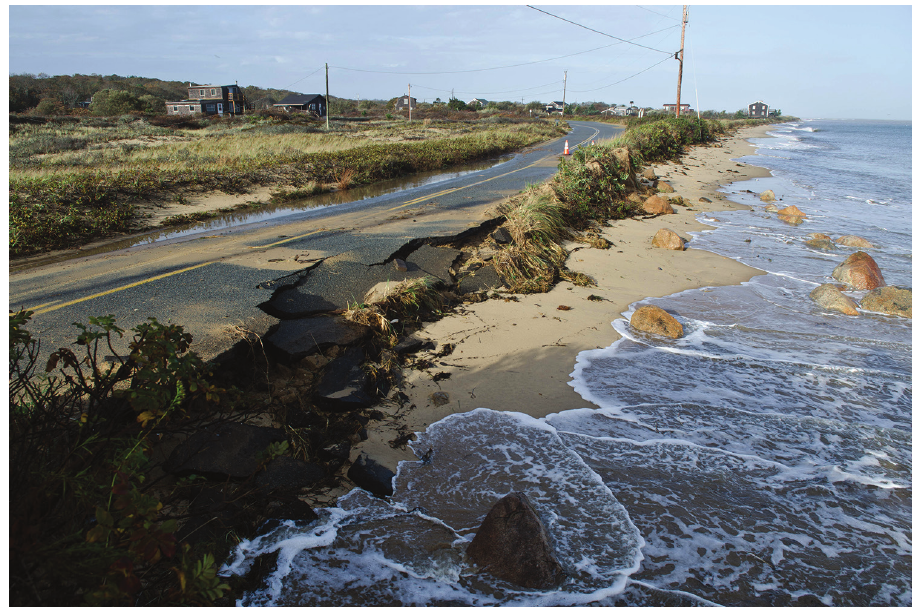
Figure 12. Damage from storm surge at Lobsterville Dunes following Hurricane Sandy, October 31, 2012 (A.O. Fisher).